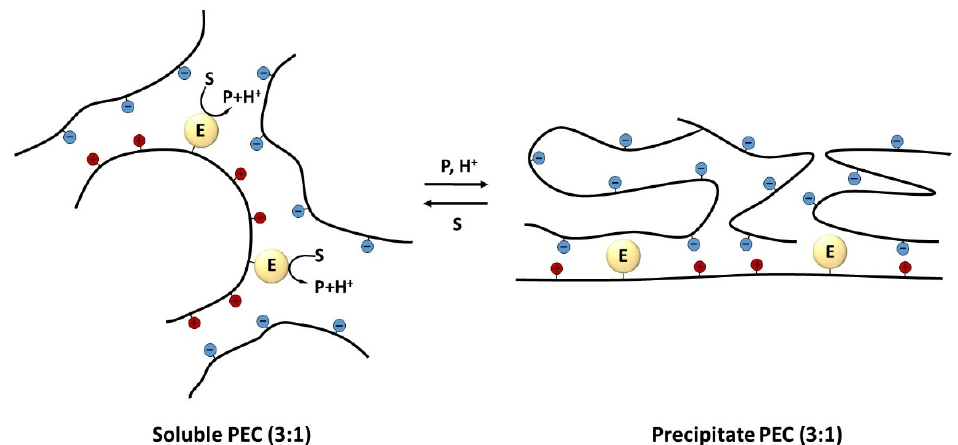
Figure 1. Self-regulated biocatalysts based on enzymes immobilized on polyelectrolytes (PEC— polyelectrolyte complex) (modified from [13]). An enzyme immobilized on polycation (E) catalyzes a reaction (S—substrate, P—product) that increases the H + concentration in the system. The polyanion (threefold excess to polycation) acidification leads to the PEC negative charge decrease, polyelectrolyte chains folding and PEC precipitation.